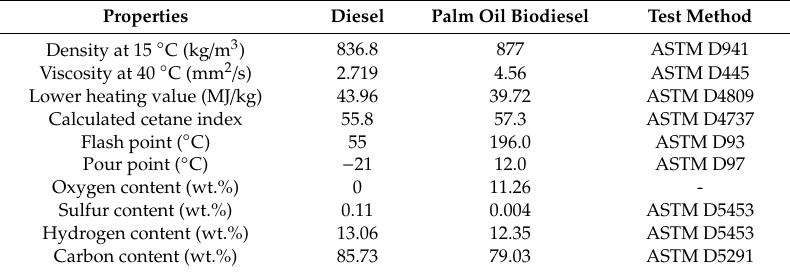
Table 1. Properties of test